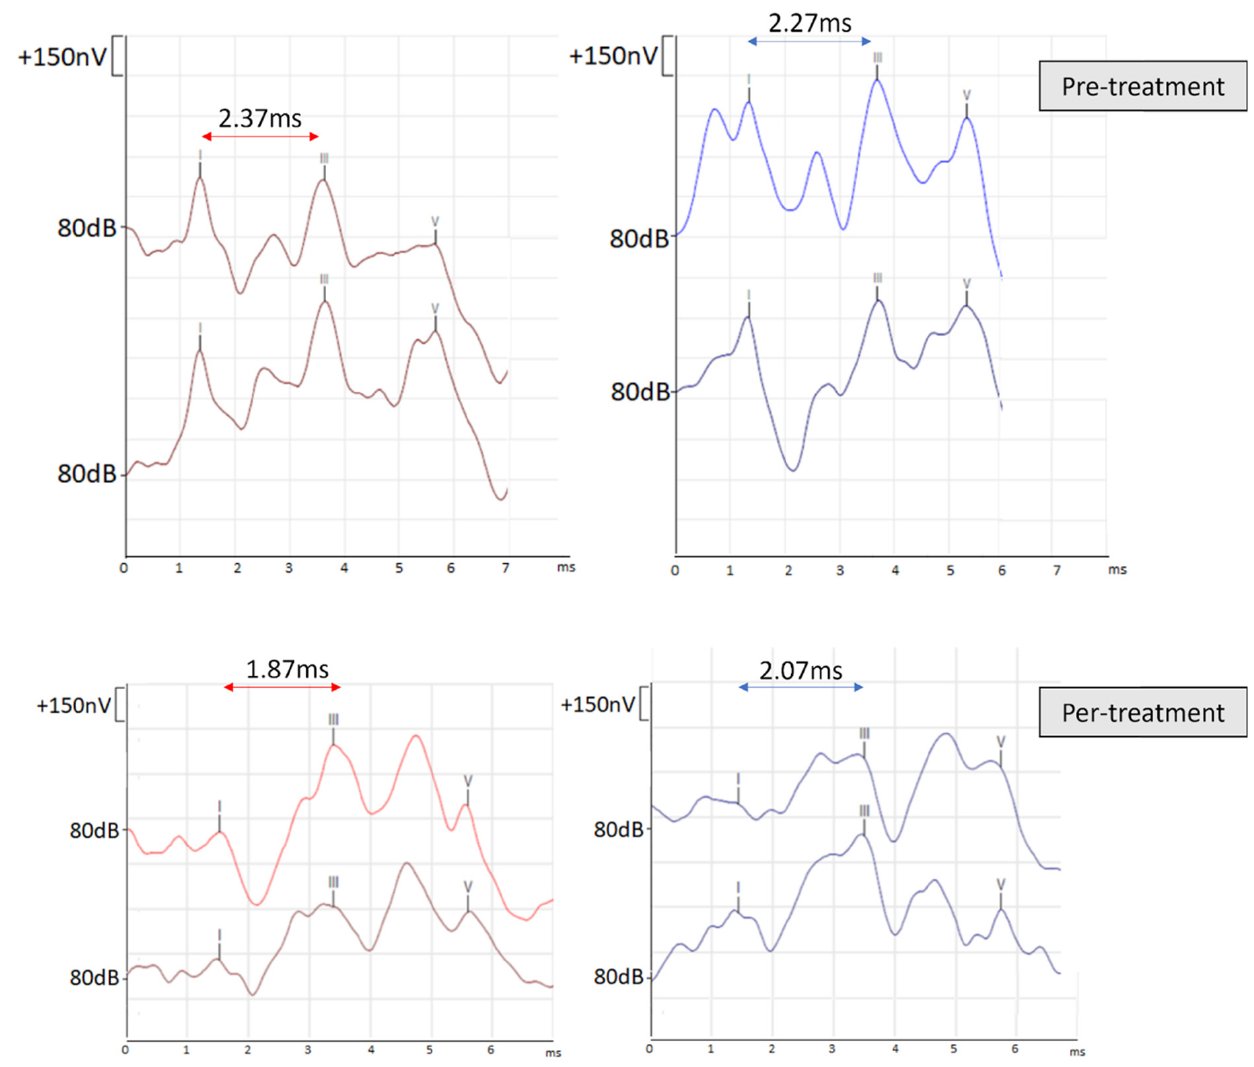
Figure 3. ABR and IPL I–III measures pretreatment and per treatment.